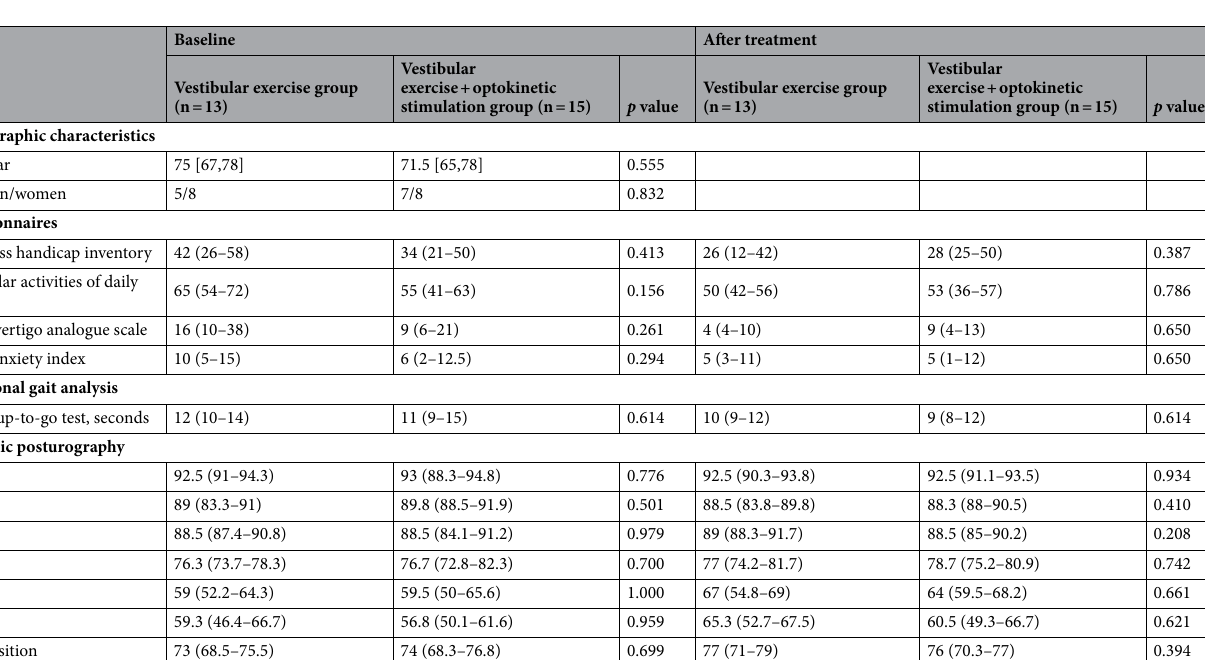
Table 1. Median scores for outcome measures at baseline and 4 weeks in the vestibular exercise group and the vestibular exercise with additional optokinetic stimuli group.